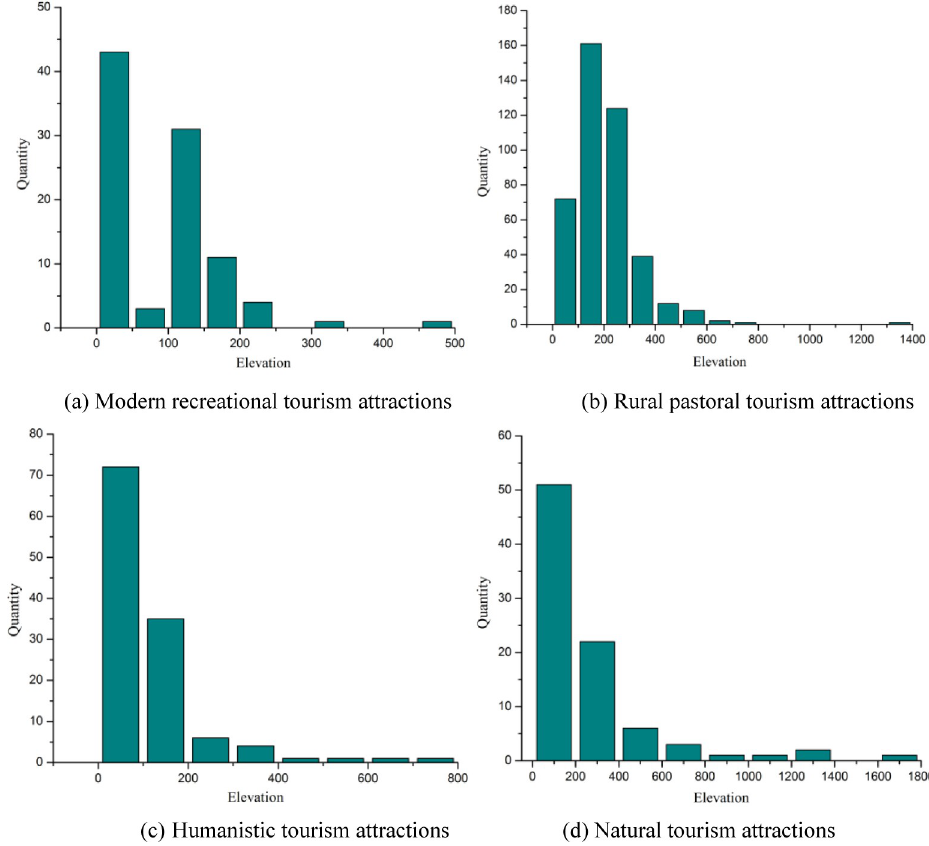
Fig 4. The elevation frequency distribution of tourist attractions in the demonstration region. (a) Modern recreational tourism attractions. (b) Rural pastoral tourism attractions. (c) Humanistic tourism attractions. (d) Natural tourism